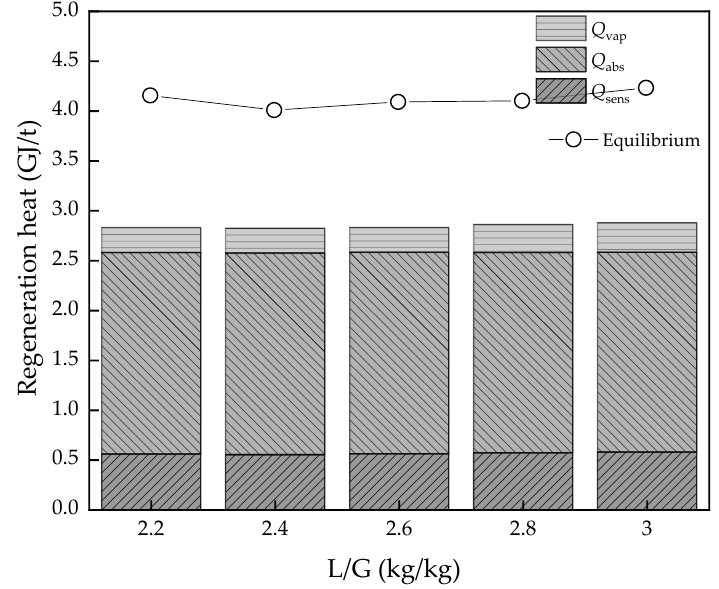
Figure 6. The regeneration heat changes with L/G value variation.